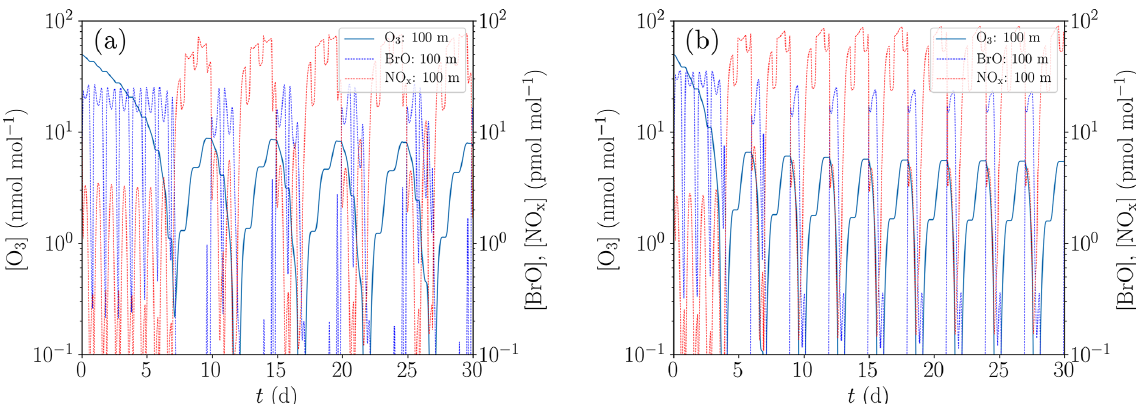
Figure 9. Simulation of the oscillations of ODEs for the conditions of Evans et al. (2003). (a) Low NO x emission and initial bromide mixing ratio of 43pmolmol − 1 . (b) Increased NO x emission by 35% and initial bromide mixing ratio of 60pmolmol − 1 .